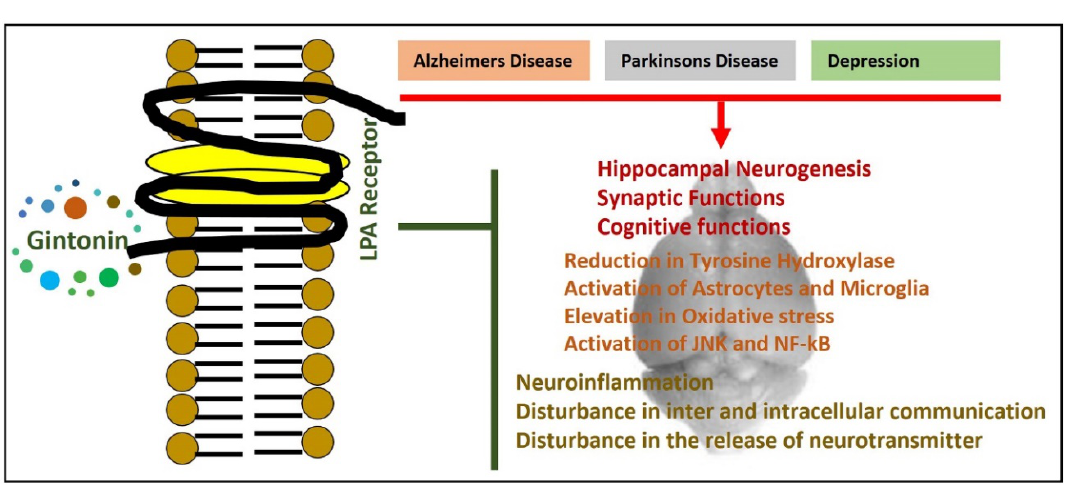
Figure 3. A simple diagram showing the role of lysophosphatidic acid in neurodegenerative disorders, and the possible therapeutic effects of gintonin. Red arrows show the pathological conditions, and green lines show the reversing effects of gintonin (as an LPA receptor agonist). LPA receptor: Lysophosphatidic acid receptors.